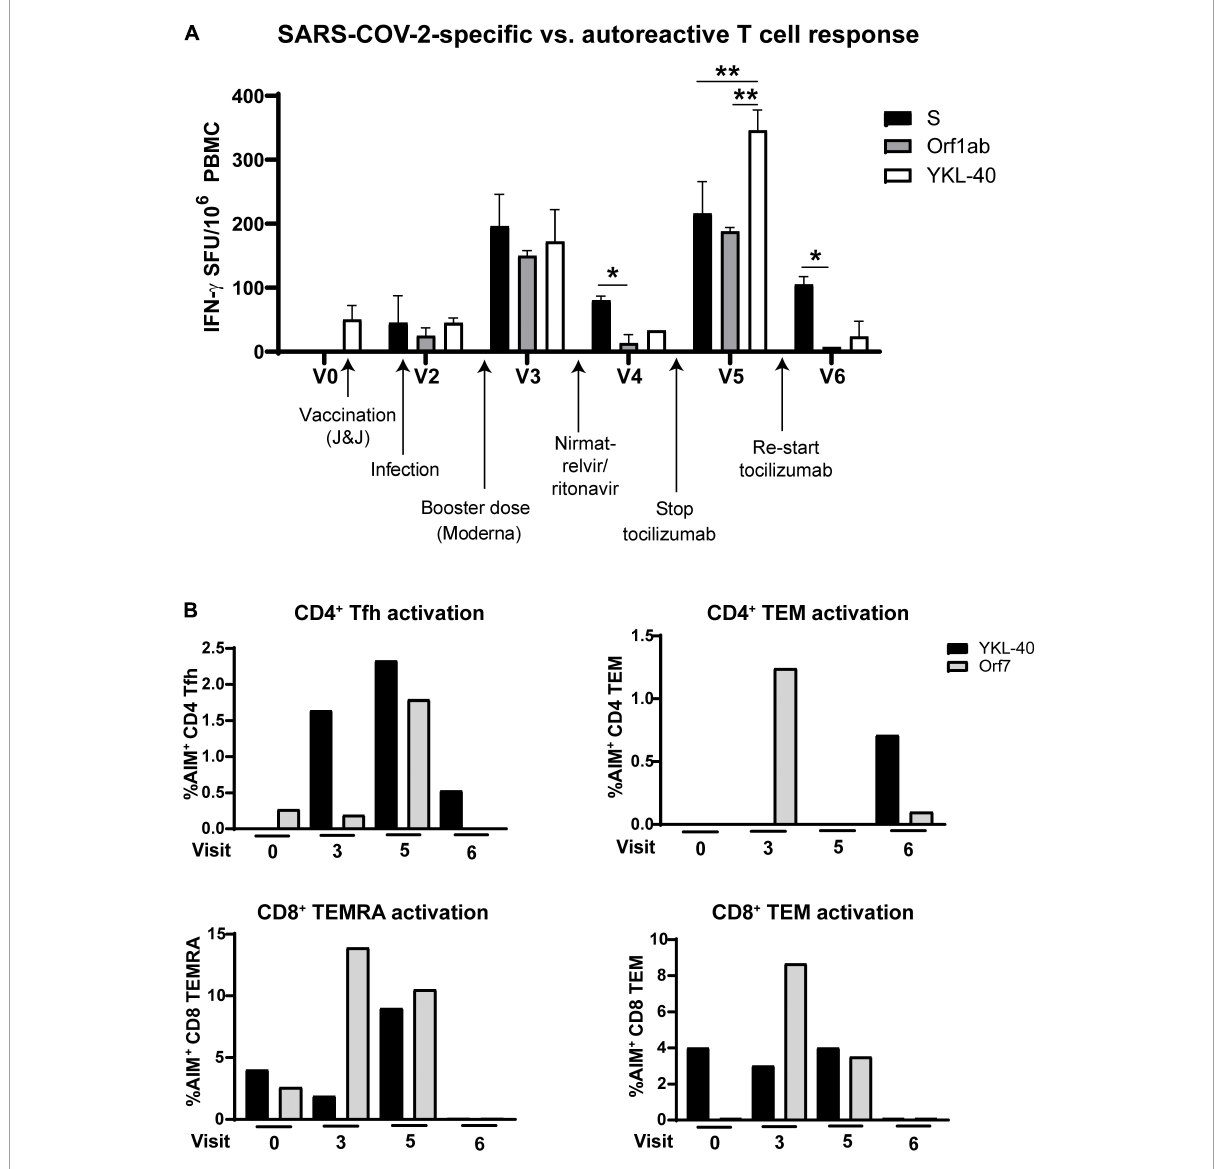
FIGURE4 Autoreactive T cell responses oscillate in coordination with SARS-CoV-2-specific responses after infection. (A) T cell production of IFN- γ after stimulation with rheumatoid arthritis-associated cartilage autoantigen YKL-40 compared with Spike- and Orf1ab-specific activation. (B) Activation of T cell subsets over the course of the study after stimulation with the rheumatoid arthritis-associated antigen YKL-40 or SARS-CoV-2 Orf7 peptides. Stopping tocilizumab resulted in increased virus-specific and autoreactive T cell reactivity, while resuming tocilizumab suppressed autoreactivity in most T cell subsets. Data representative of 2 individual experiments, * p < 0.05, ** p < 0.01 by one-way ANOVA with Tukey’s